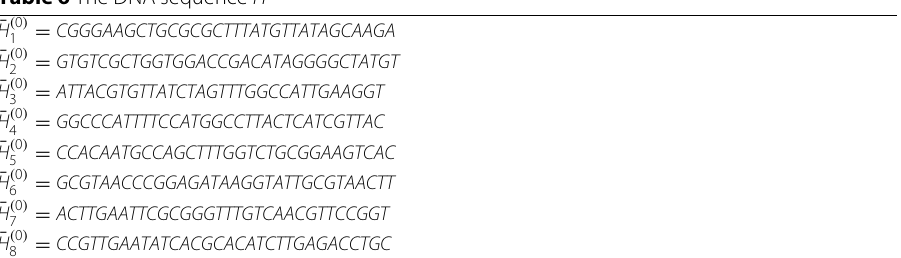
Table 6 The DNA sequence ¯ H ( 0